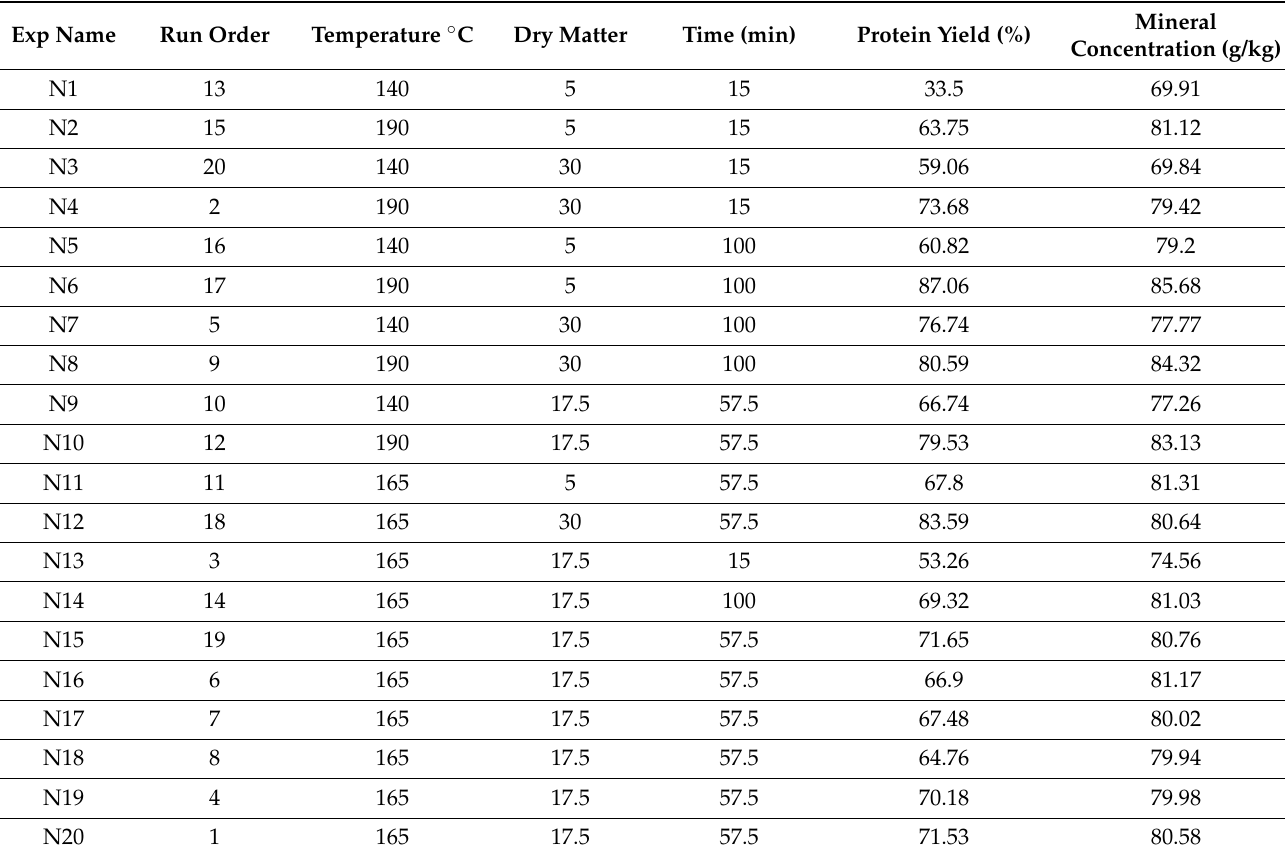
Table 2. CCF design for optimization of bone treatment for collagen peptide